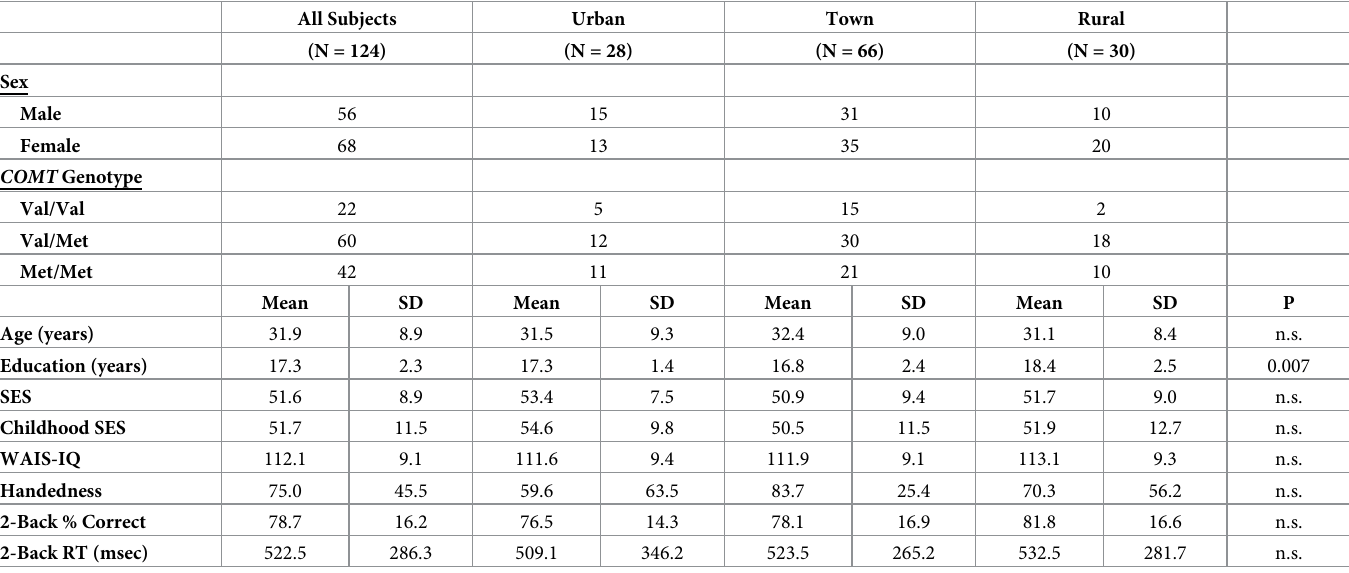
Table 1. Demographic characteristics and working memory performance (Discovery